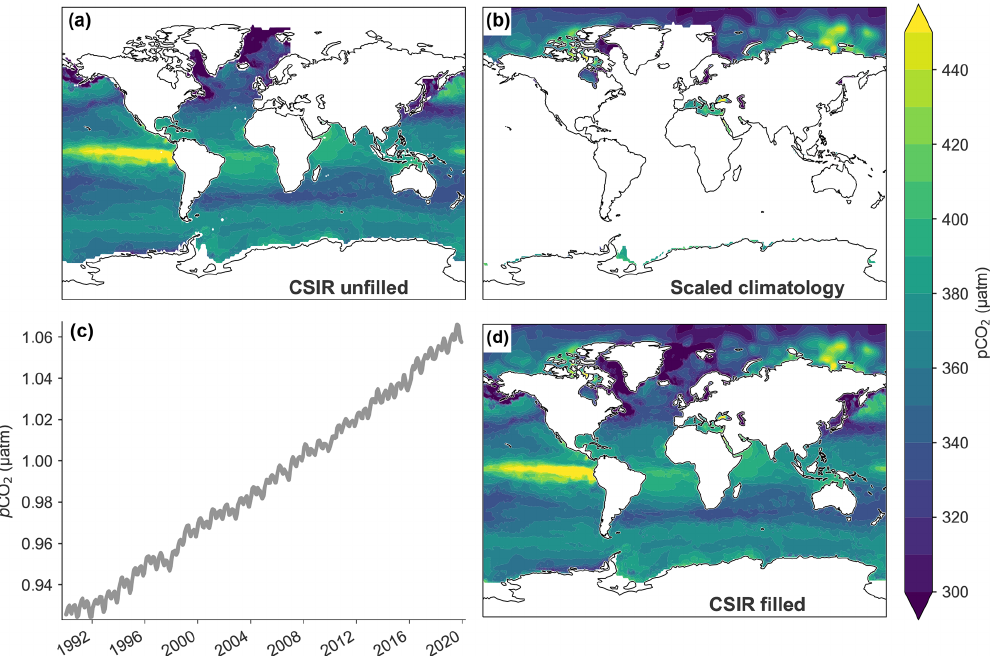
Figure 2. Maps demonstrating the filling procedure employed in this study using a snapshot of p CO 2 from May 2013. (a) Map of unfilled CSIR-ML6 p CO 2 . (b) The scaled p CO 2 climatology of Landschützer et al. (2020b). (c) The mean p CO 2 for the scaled climatology over time. (d) The CSIR-ML6 p CO 2 product (a) filled using the scaled climatology (b)